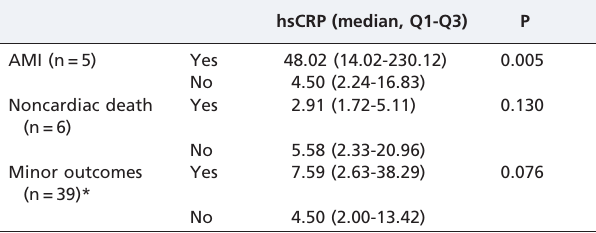
Table 2 - Median and quartiles of CRP levels in the groups with and without events